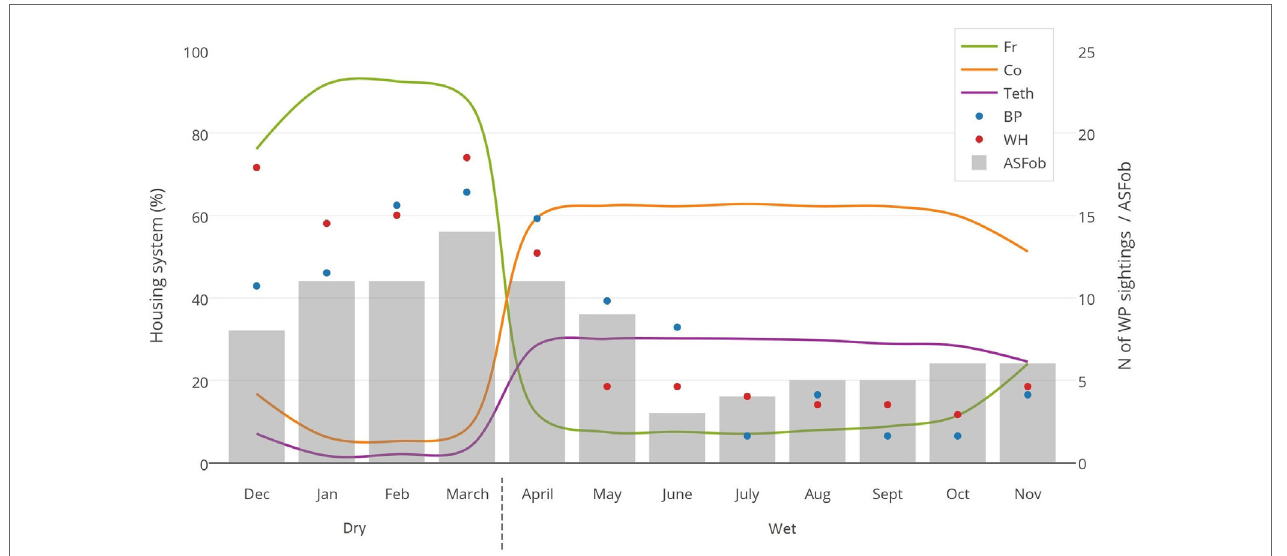
FigUre 2 | Monthly evaluation of three variables collected during individual interviews with 233 pig owning household in nwoya District, Uganda, in 2015 . Lines represent the type of housing system used (Fr, free range; Co, confined; Teth, tethered); dots represent the number of wild pig sightings (BP, bushpig; WH, warthog); and bar charts represent the number of ASF outbreaks (ASFob, ASF outbreaks) during the dry and wet